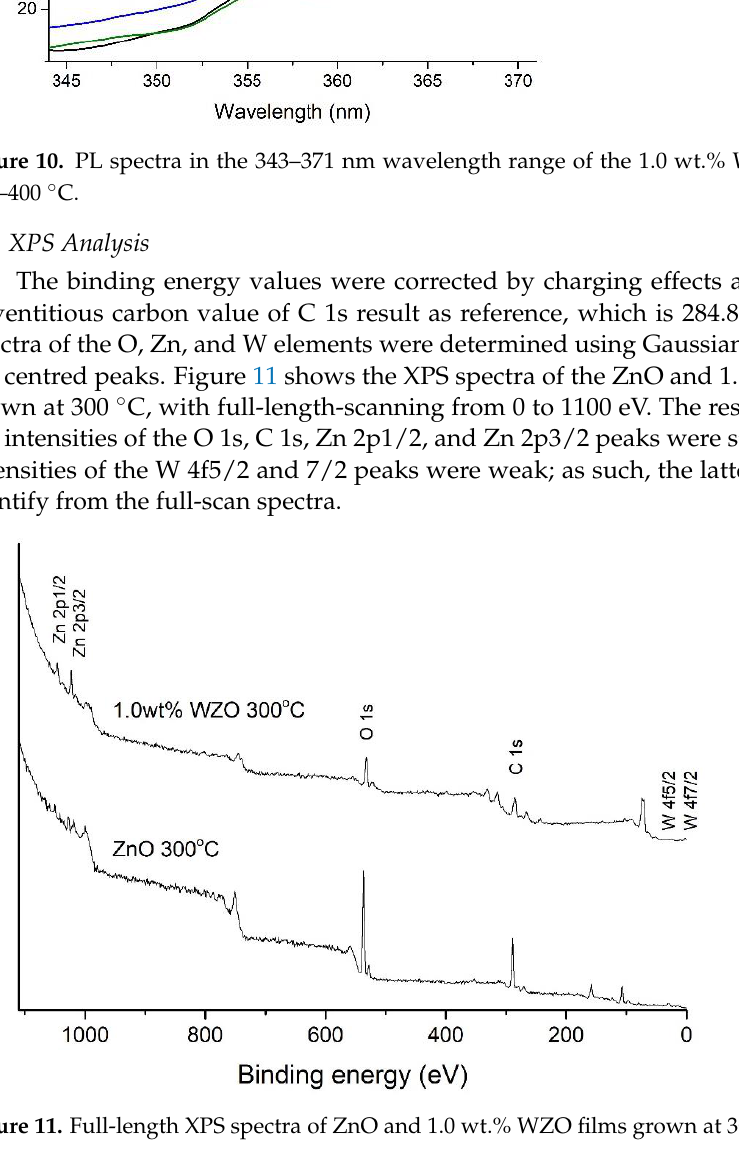
Figure 11. Full-length XPS spectra of ZnO and 1.0 wt.% WZO films grown at 300 °C. The C 1s XPS peaks of the 1.0 wt.% WZO films grown at 250 °C, 300 °C, and 350 °C, and ZnO film grown at 300 °C, are illustrated in Figure 12. The peaks corresponding to the C-C and C-O bonds can also be identified [32].